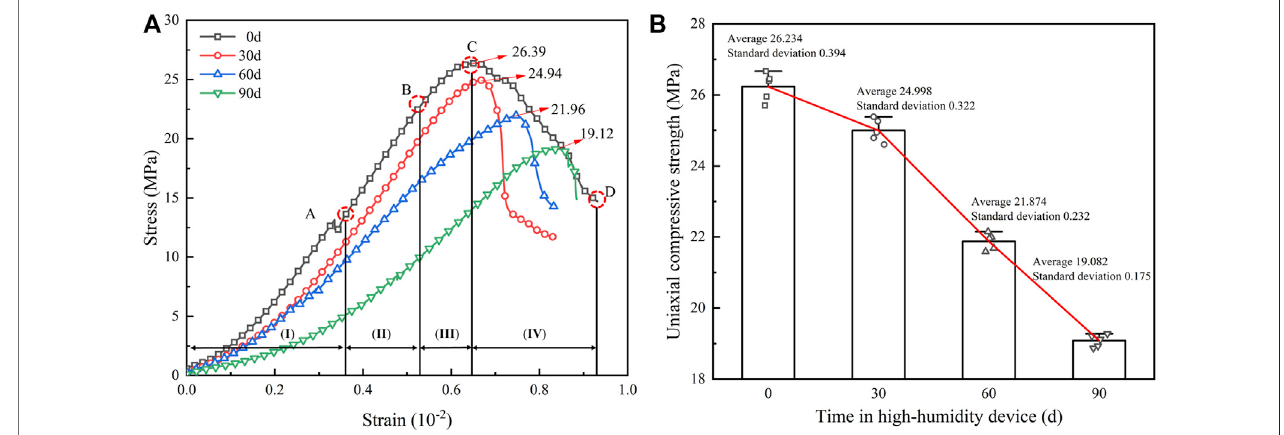
FIGURE 7 | Uniaxial compression law of dolomite samples under different high-humidity times: (A) Stress-strain curves; (B) Uniaxial compressive strength.